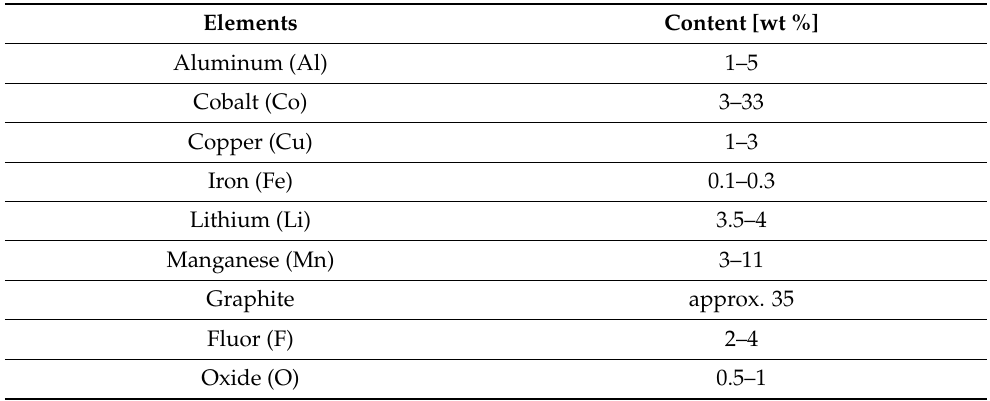
Table 5. Concentration ranges of major black mass components produced from layered oxides chemistries, according to